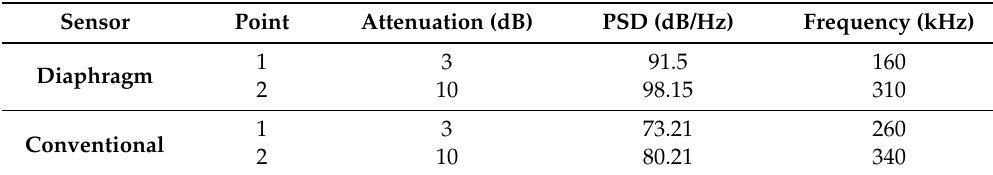
Table 3. Frequency and attenuation of each point highlighted in Figure